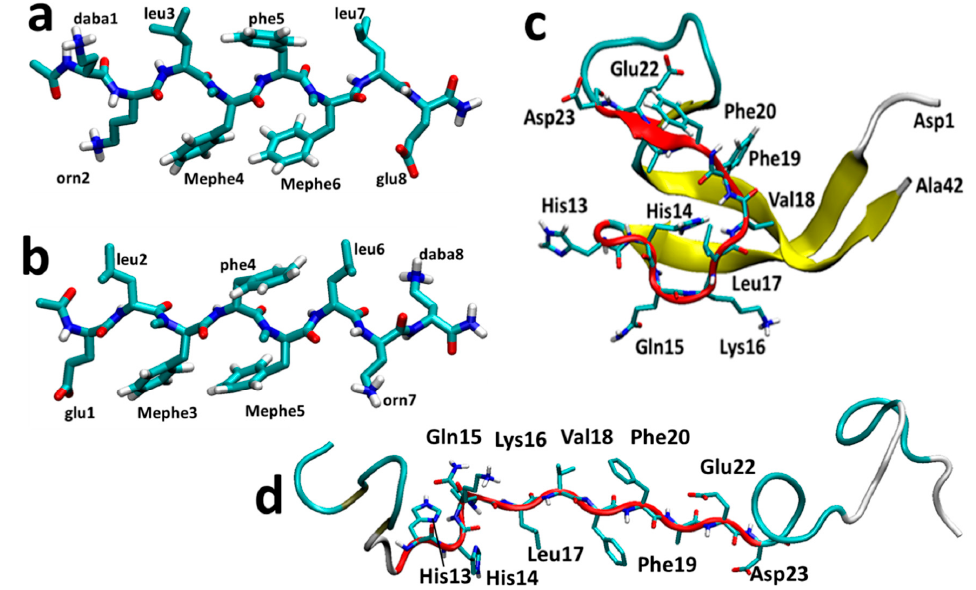
Figure 1. The most stable structures of SGB1 ( a ) and SGD1 ( b ) obtained from the MD simulation. The numbering is from the N-terminal amino-acid. ( c ) Reference geometry of A β 42 . ( d ) Extended geometry of A β 42 for docking. The R region of A β is highlighted as a red cartoon with side chains.